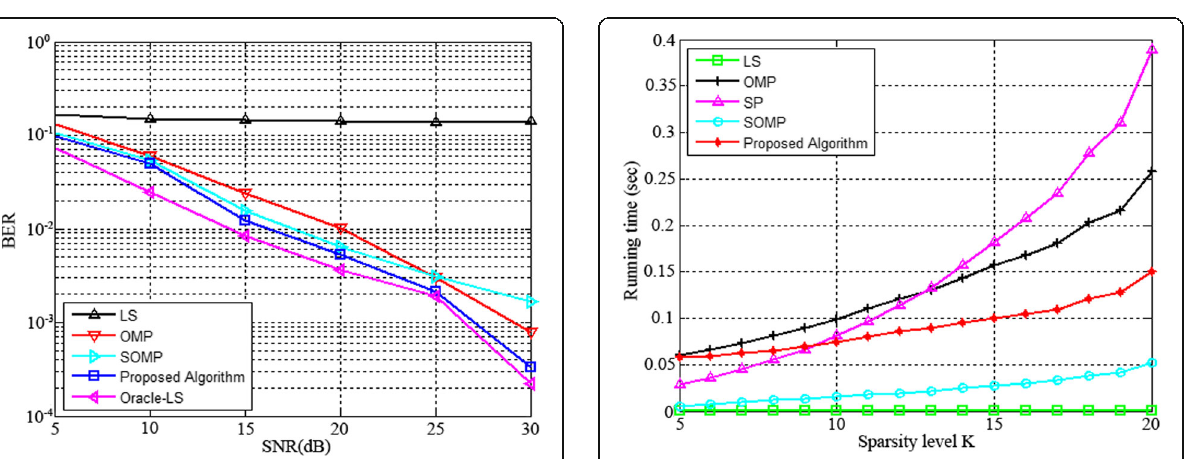
algorithm Oracle-LS in the simulation of this group is the LS estimation when the multipath delay set of time-varying sparse channel is known, and this re- sult is the theoretical limit value under the LS (d) Analysis of algorithm complexity under different channel sparsity.